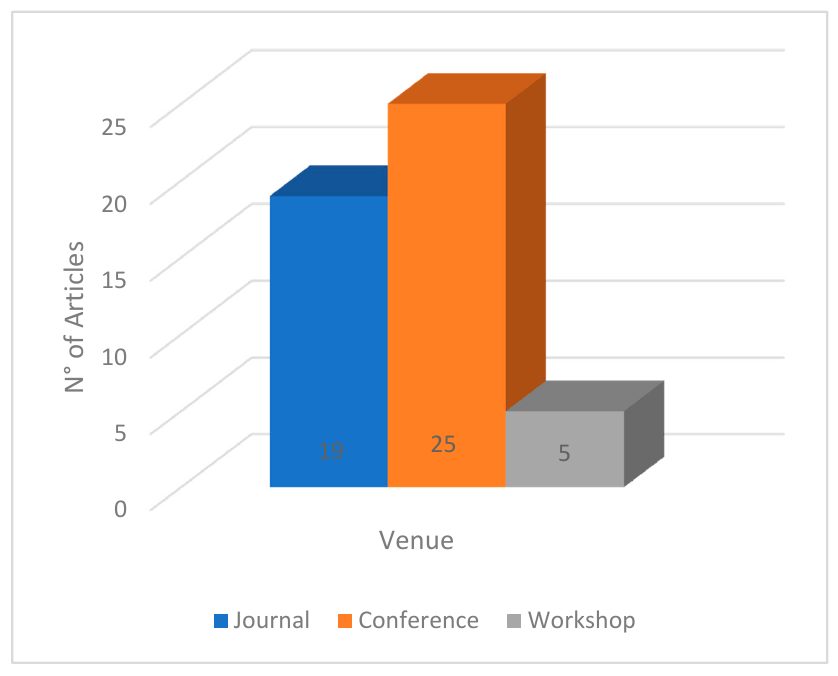
Figure 4. Venue of publication.